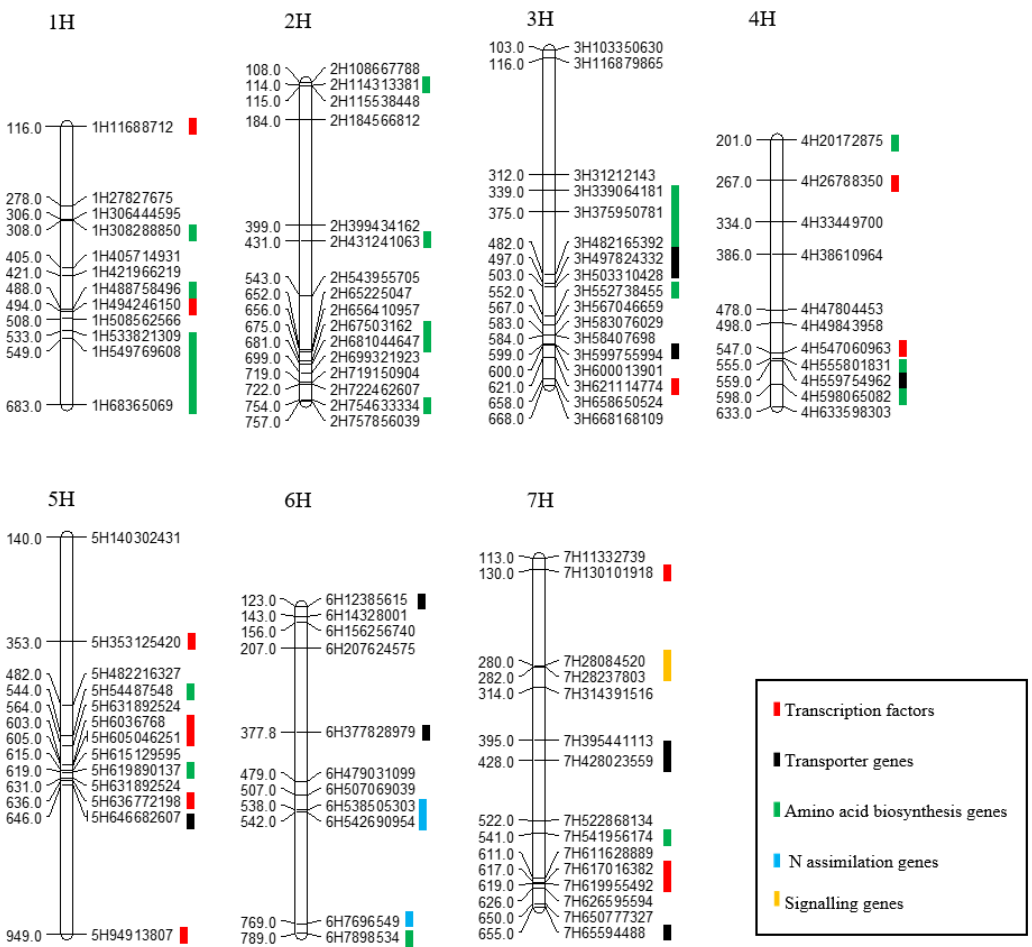
Figure 1. Physical positions of the major candidate gene families for NUE on barley chromosomes. The candidate gene families based on their annotation are indicated on the right side of the chromosome (MapChart 2.32: https://www.wur.nl/en/show/Mapchart.htm).